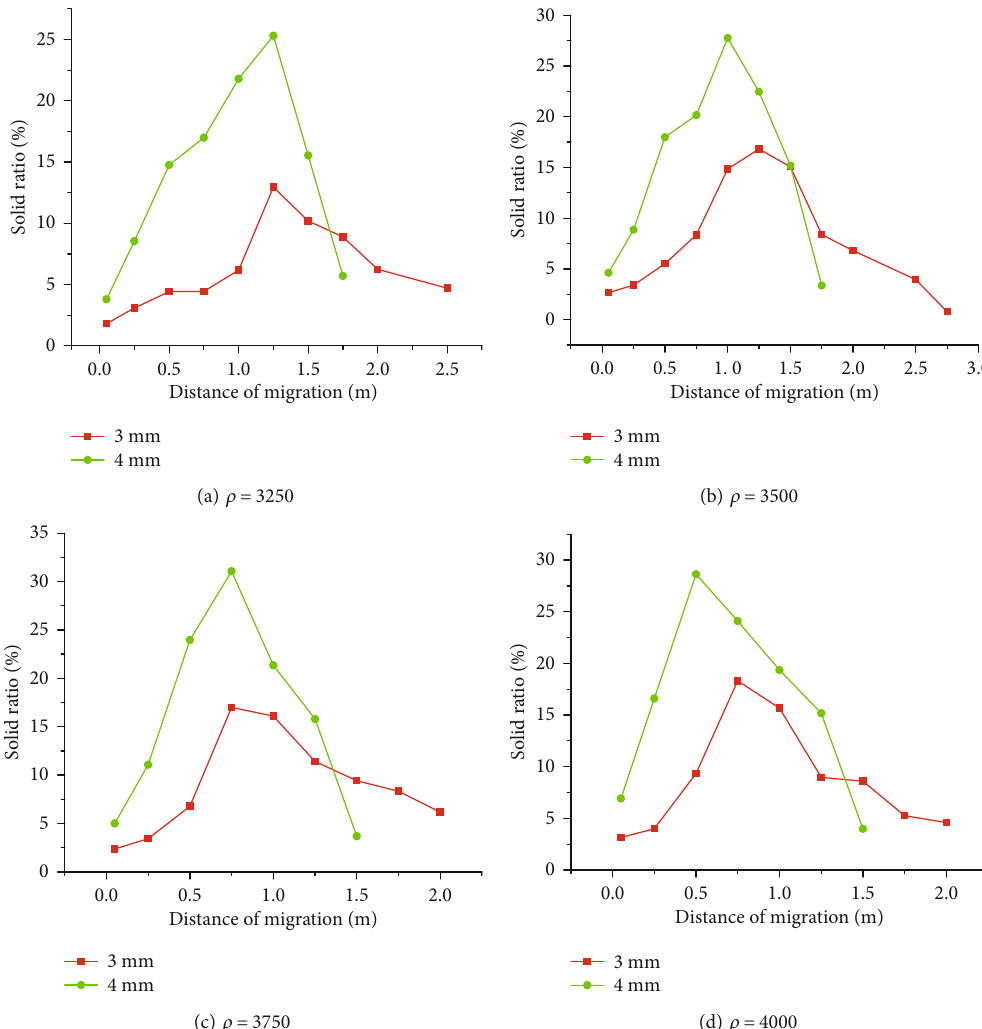
Figure 11: Variation of solid ratio of aggregate particles of di ff erent particle sizes with grout fl ow at di ff erent